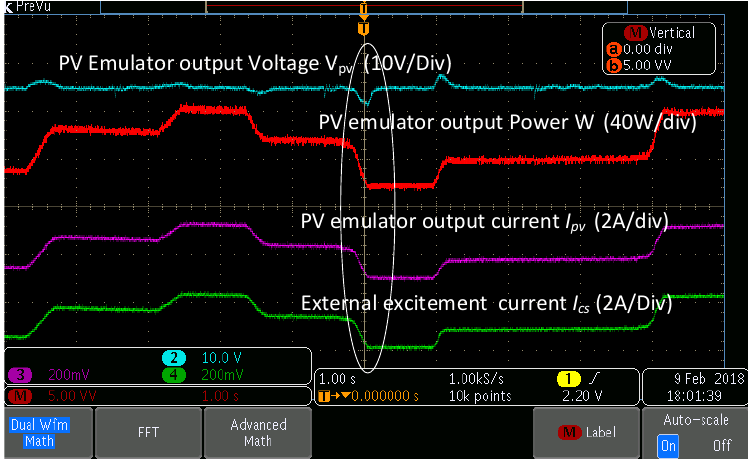
Figure 14. MP&O fuzzy logic controller Variable step size MPPT Test results with variable current source currents (emulating the variable photo-generated current).